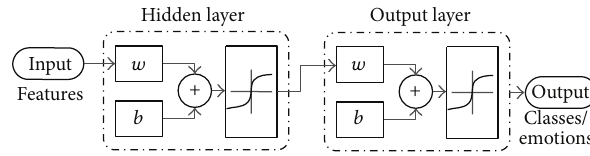
Figure 2: Artificial neural network architecture with hidden layers and output